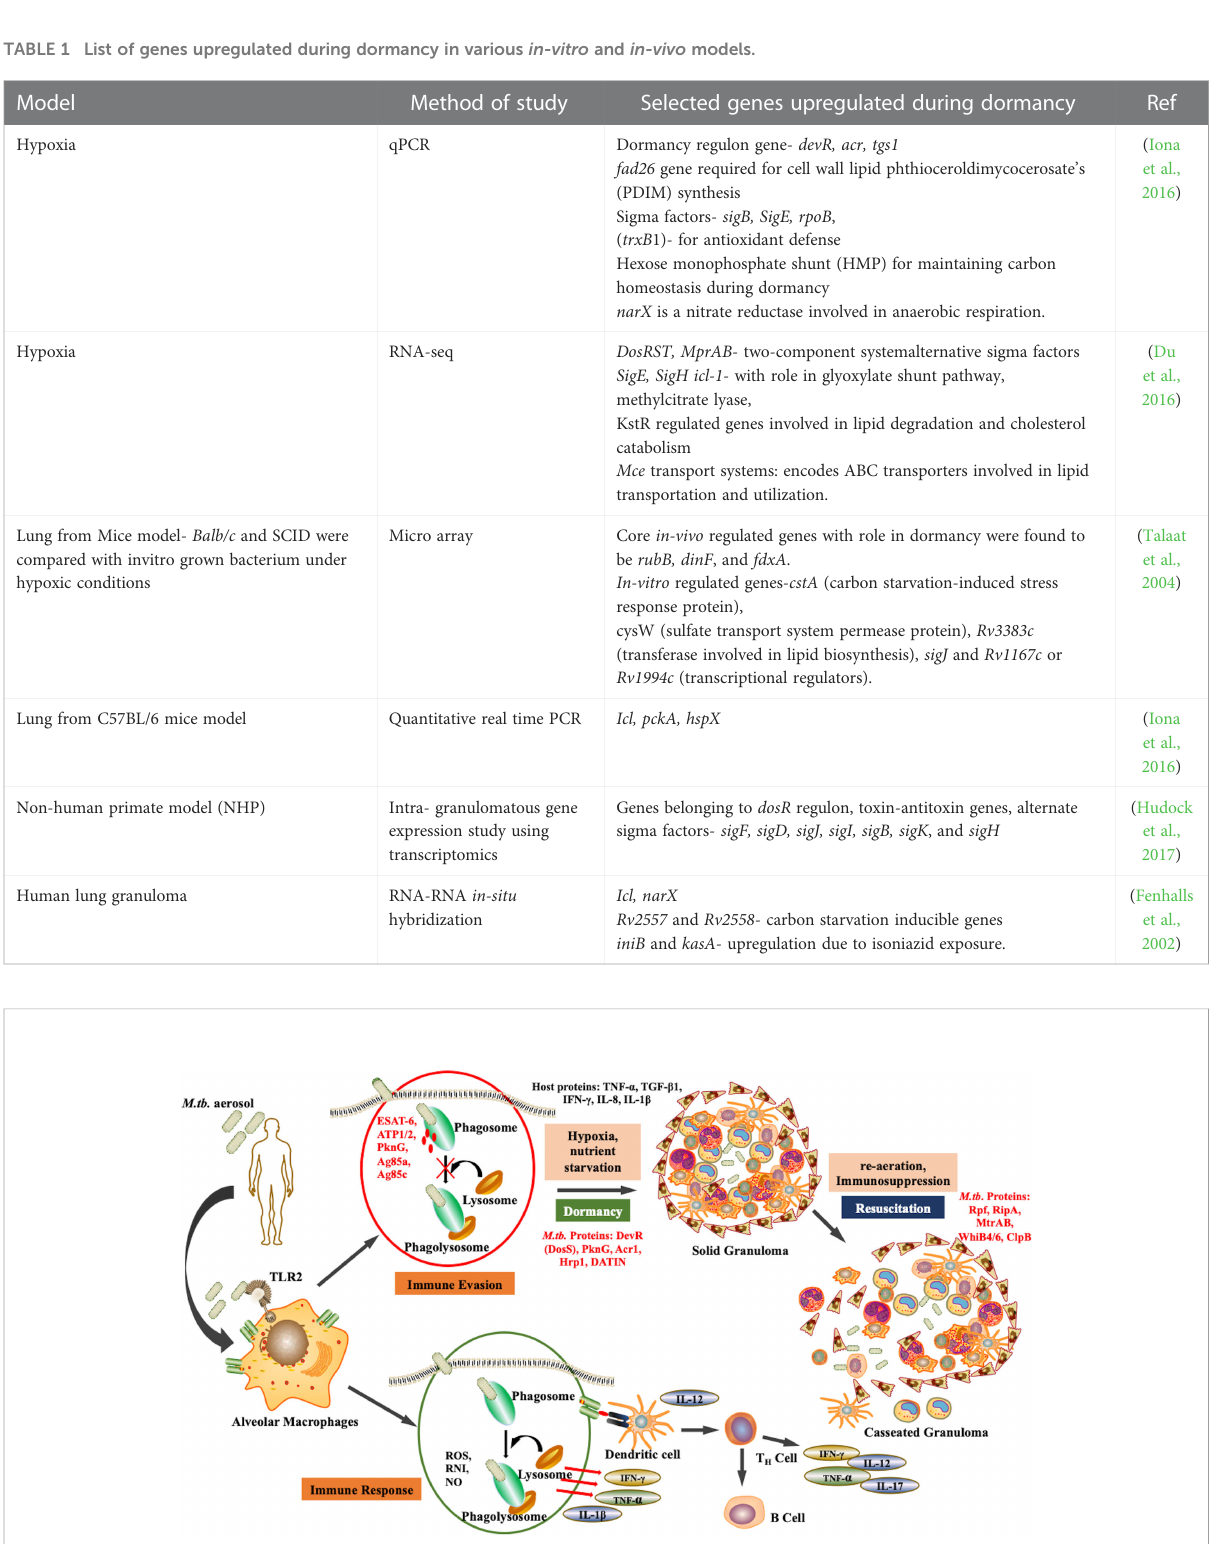
FIGURE 1 Pathogenesis of M.tb : Upon aerosol inhalation, alveolar macrophages degrade bacteria through ROS production and phagolysosomal degradation, which activates other immune cells such as T cells and B cells, further providing defense against the pathogen. However, M.tb. adapts the ability to inhibit phagolysosomal degradation, and therefore under unfavorable conditions such as hypoxia undergo dormancy. As the environmental conditions become favorable, the bacteria resuscitate, resulting in active disease. (Red represents M.tb. antigens).